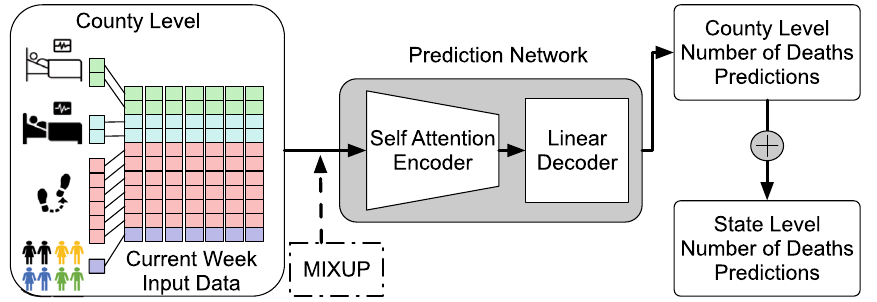
Figure 3. Overview of prediction flow. The county-level and state-level predictions for weekly total number of deaths are for the next week (Week 1) and the second week (Week 2) from the current week (Week 0) input